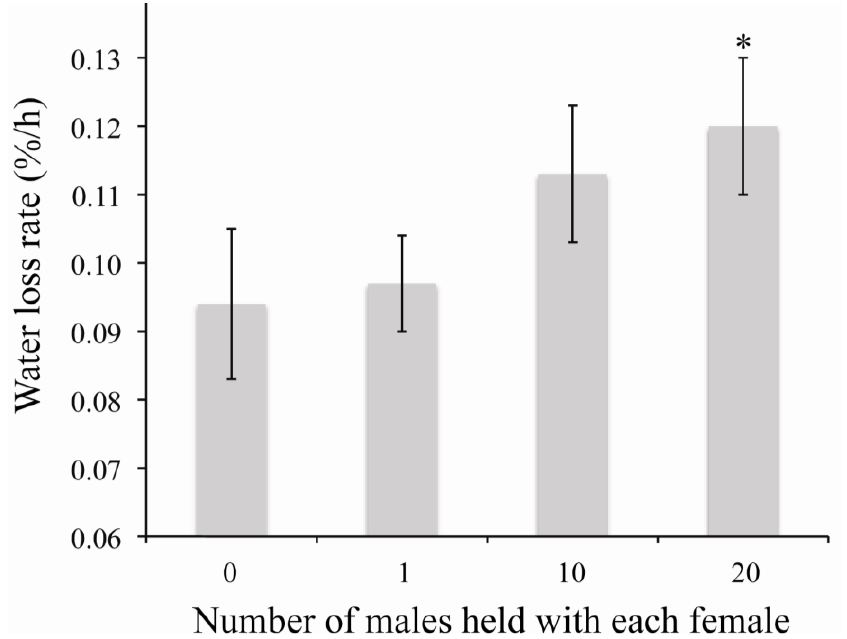
Figure 1. Proportion of water mass lost at 0% relative humidity (RH) and 25 °C after removal of an individual female held in containers containing 0, 1, 10 and 20 males for 6 h. Water loss rates were determined according to Benoit et al. [39]. Water loss rate is presented as percent water lost per hour. Data represents the mean ± SE, N = 30.*, significantly different from 0 males (P <